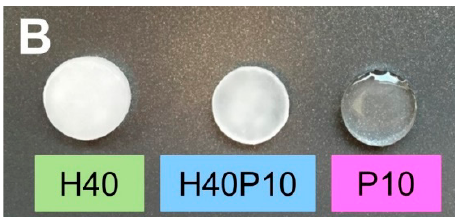
Figure 2. Gelation point measurements ( A ) of the different pure hydrogel systems composed of 40 wt% 2-hydroxyethyl methacrylate (HEMA) (H40), 10 wt% PEG-PLLA-based hydrogel precursor (P10) or a combination of both (H40P10) at 16 °C over 30 min. Image B depicts the structure of the different hydrogel samples with a very turbid and milky look of the HEMA sample to the clear and transparent PEG-PLLA-hydrogel.